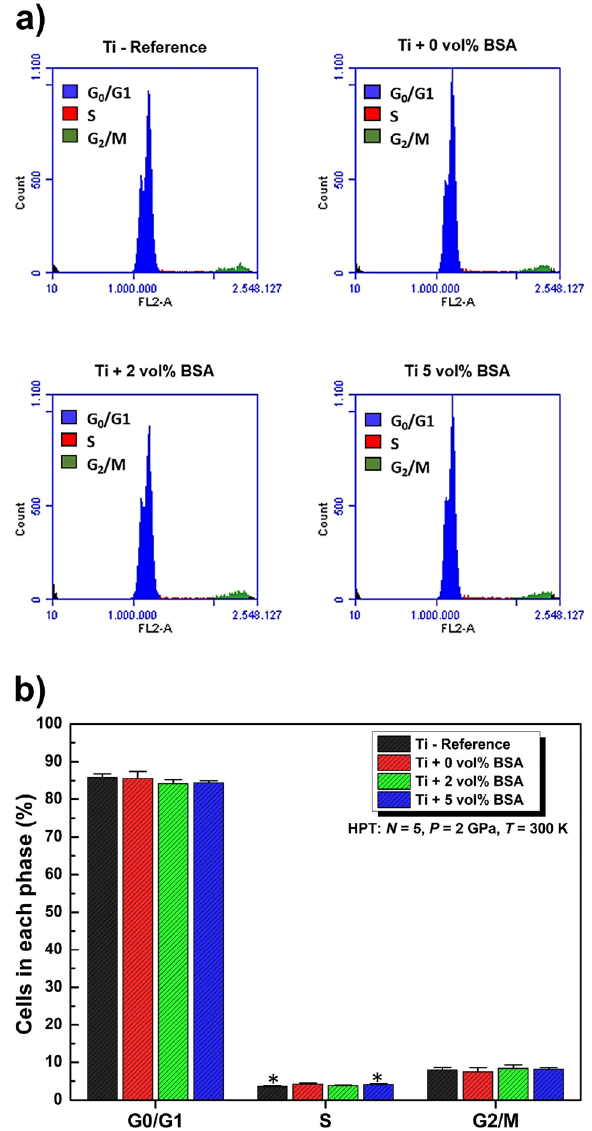
Figure 6. Cell cycle profile of MC3T3-E1 cells. ( a ) Representative histogram for the samples showing distribution of cells in the individual phases of cell cycle in the G0/G1 (Blue), S (Red), and G2/M (Green) phases. ( b ) Quantitative analysis of distribution or proportion of the cell numbers in each phase, performed from at least 10,000 events per sample. Data are shown as mean ± standard deviation of experiments performed in quadruplicate and compared by Kruskal–Wallis ANOVA and pairwise comparisons by Mann–Whitney